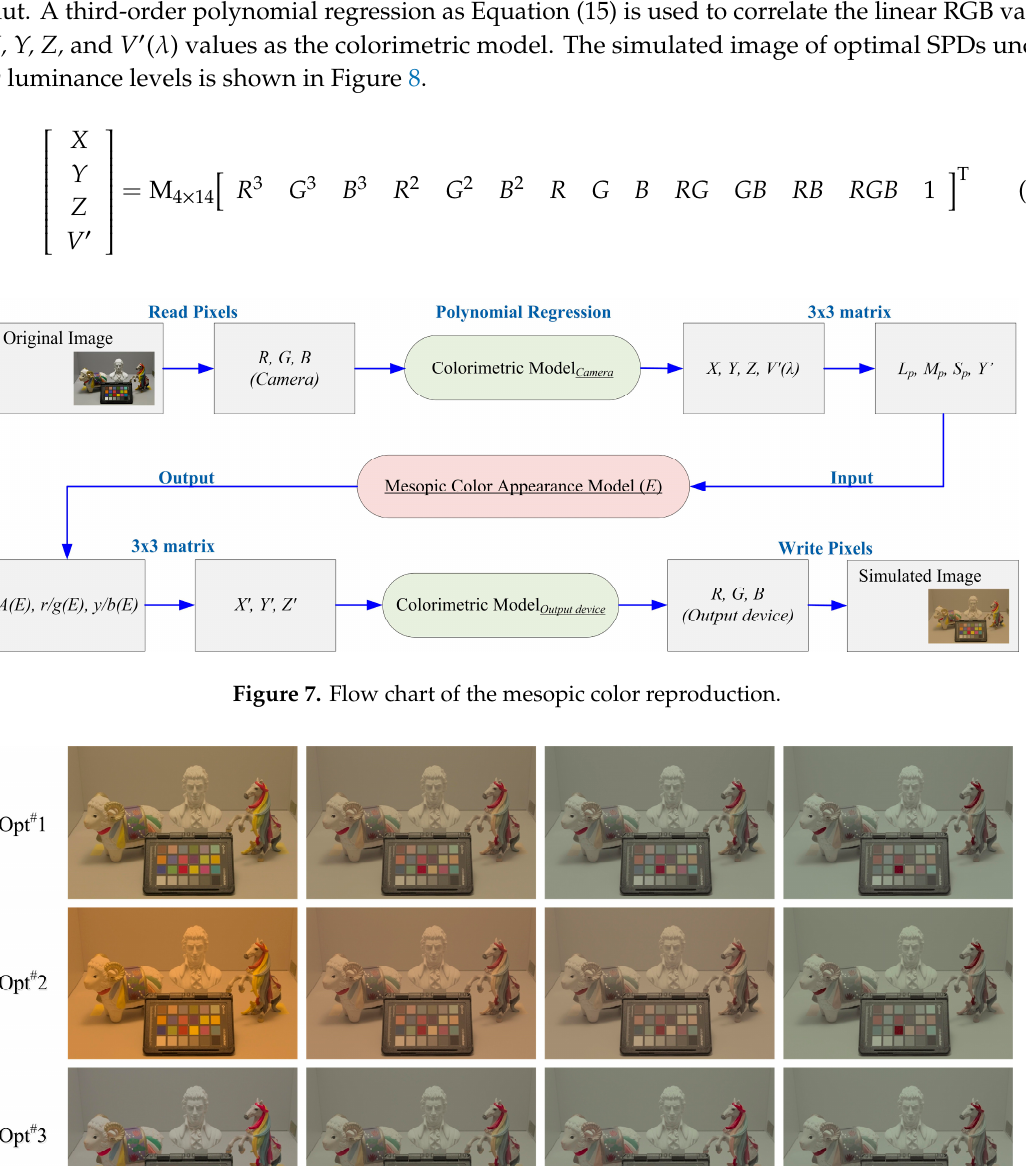
Figure 6. Characteristic of luminance and gamut volume of different power density ratios (left to right: blue, green, and red).